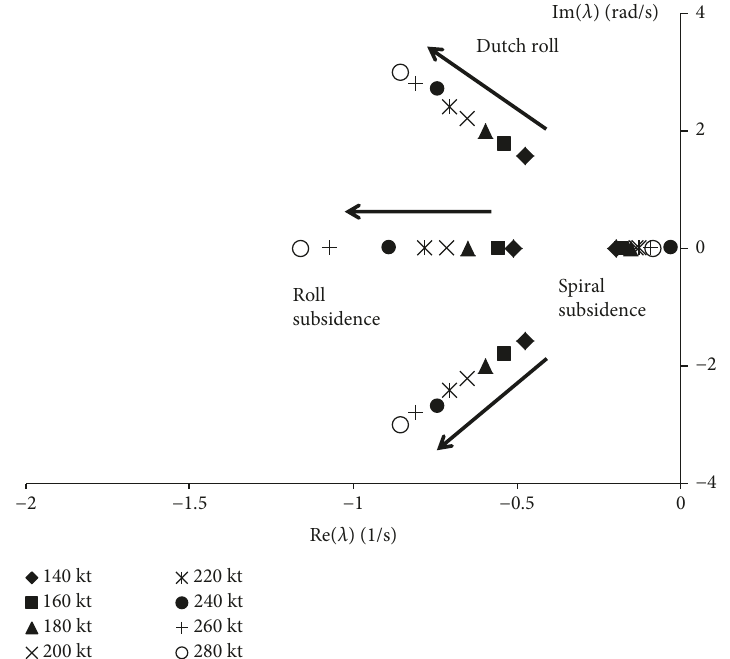
Figure 23: Lateral eigenvalue movement in airplane